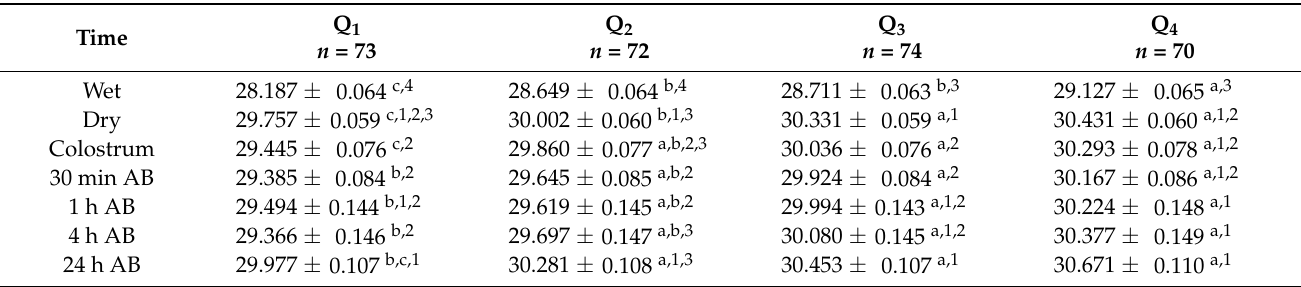
Table 2. Average of the temperature of nasal (N) window at different times in newborn puppies classified into 4 groups according to its weight.